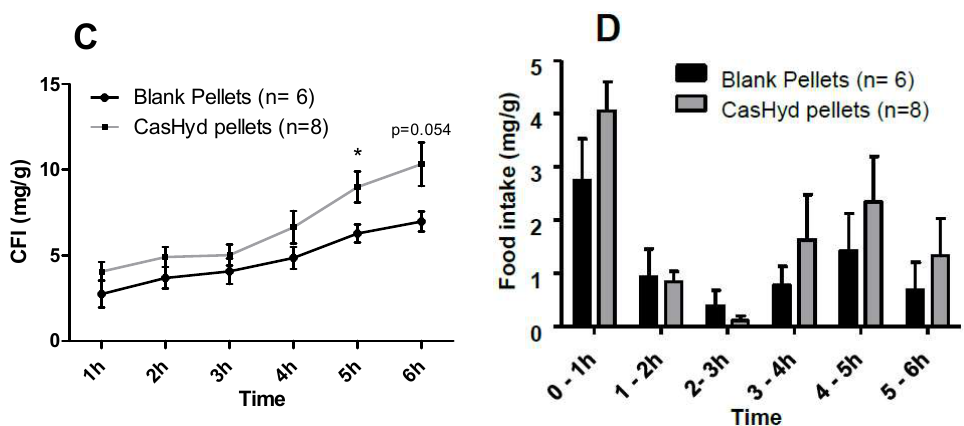
Figure 12. Cumulative food intake following oral administration of gastro-protective pellets containing casein-derived hydrolysate. Food (regular chow) intake in male ( top ) and female ( bottom ) Sprague-Dawley rats was determined following oral gavage with 35 mg kg -1 dose of encapsulated CasHyd over 6 h. Cumulative food intake (CFI) was determined at regular intervals, beginning 4 h after oral gavage of the coated pellets containing CasHyd, or an equivalent weight of blank pellets ( A , C ) The food intake per time bin is also illustrated ( B , D ). Graphs represent the mean ± SEM. Statistical significance was determined using repeated measures ANOVA and estimation of parameters for food intake. Pairwise comparisons were carried out using Tukey’s post-hoc test, while an independent samples t -test was used for each individual time bin; statistical significance is depicted as * p < 0.05.